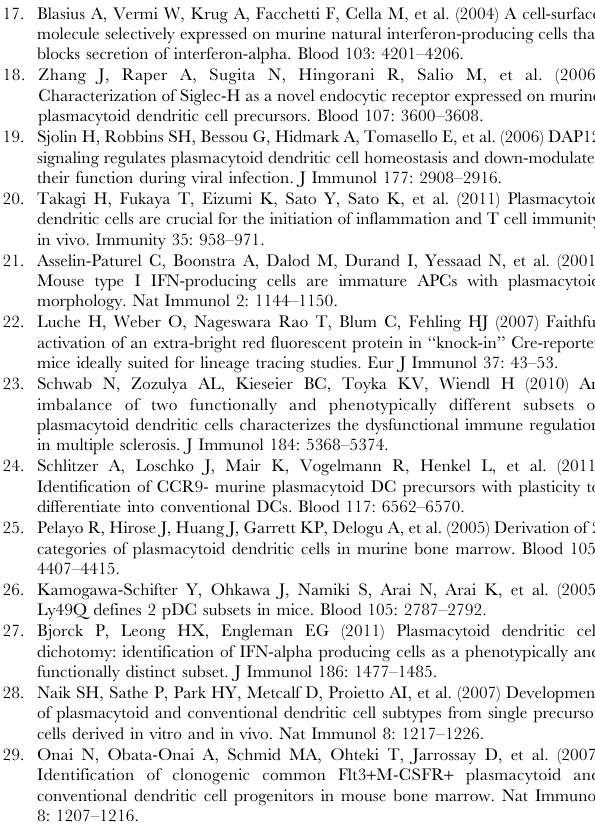
Figure S3 Co-expression of CD86 versus Siglec-H on BMDCs at 0, 3, 6 and 24 h p.i. Flt3-L derived mixed BMDCs were MCMV-GFP infected at MOI 2. Cells were gated on live CD11c + GFP 2 and CD11c + GFP + DCs. ( A ) Gating strategy. ( B ) Co-expression of Siglec-H versus CD86 expression. Results are representative for 3 independent